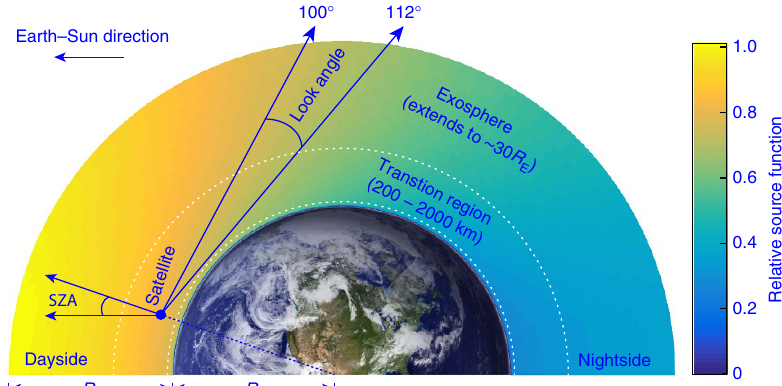
Figure 1 | A schematic diagram of the Global Ultraviolet Imager observational geometry. The TIMED satellite is orbiting at 625km and viewing in the anti-sunward limb direction. One example of the source function calculated using the radiative transfer model described in Methods is shown. The Earth image is taken by NASA. Note that the actual simulation domain extends up to B 30 R E , where R E represents the Earth radius. SZA is the angle between the zenith and the Earth-sun